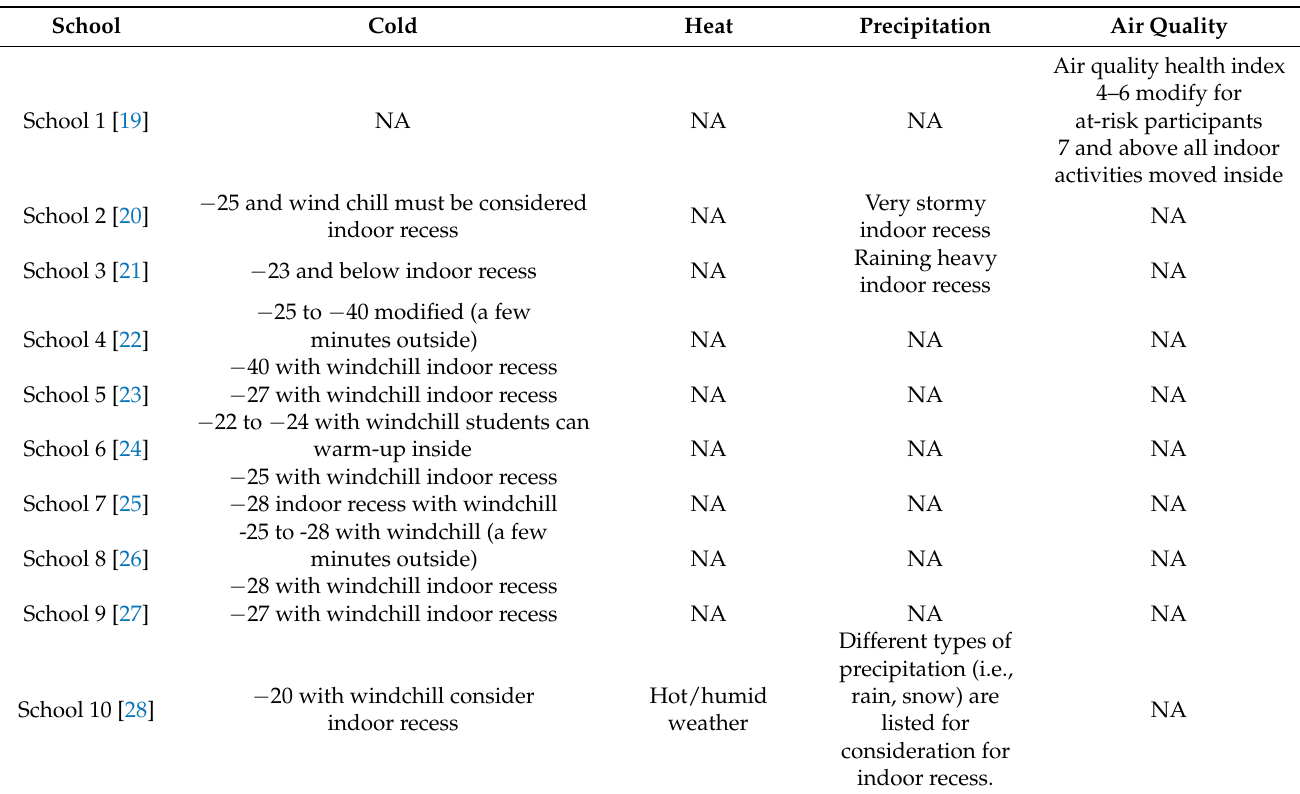
Table 1. School weather and recess policies from 14 Canadian